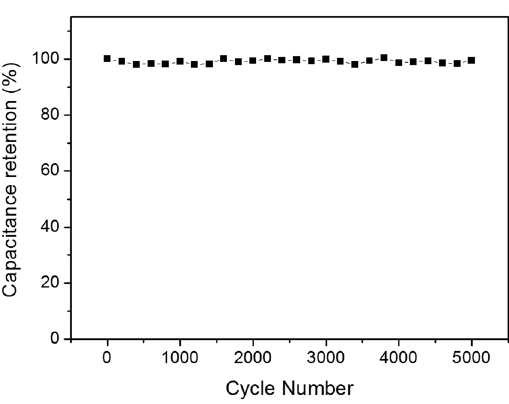
Figure 9. The long cycle stability of BFH-850 at a current density of 15 A g − 1